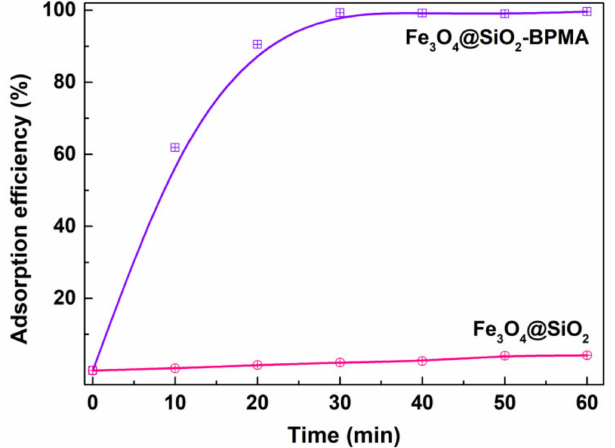
Figure 9. Time-dependence of adsorption profiles of Cd 2 + ion onto Fe 3 O 4 @SiO 2 and Fe 3 O 4 @SiO 2 -BPMA powders (adsorption conditions: room temperature; no pH pre-adjustments;